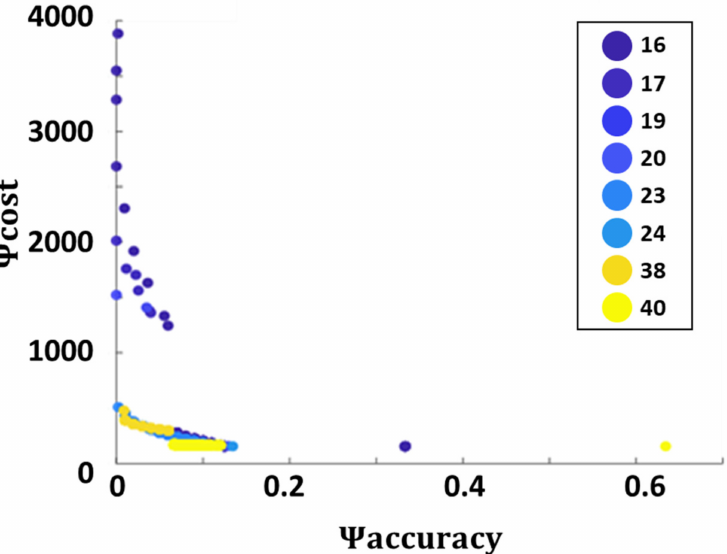
Figure 3. The Pareto frontier was obtained by using a high-end sensor array when source #5 was leaking at a rate of 2.5 kg/s. Feasible solutions obtained at different detector array distances are marked with solid circles. Note that the feasible accurate solutions are located at 38 and 40 gu from the